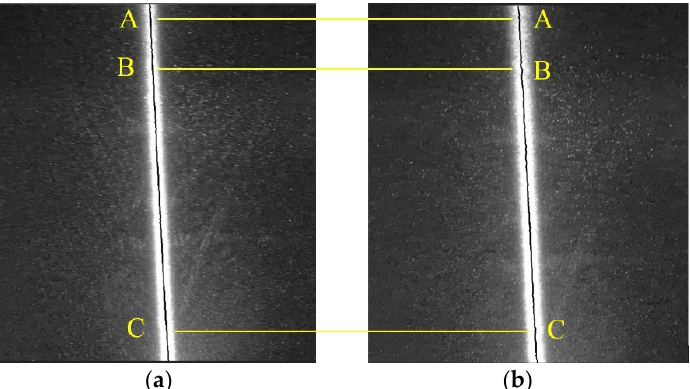
Figure 11. Comparison of local waggle points. ( a ) The proposed method. ( b ) The standard method.